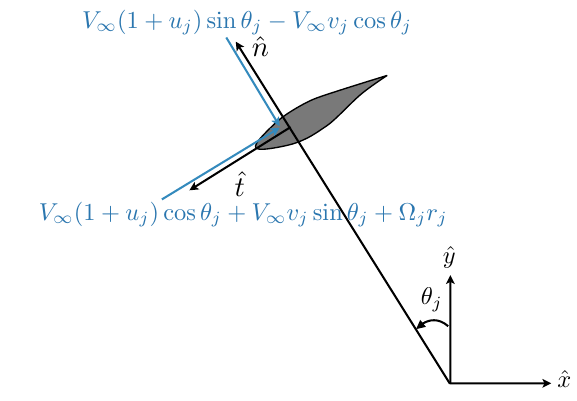
Figure 9. Components of velocity resolved into ˆ n − ˆ t plane.